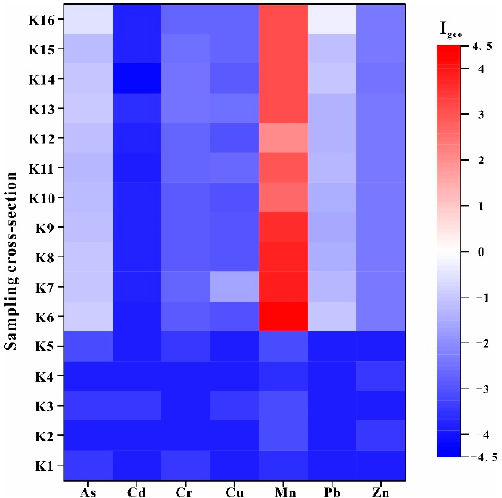
Figure 7. The I geo distribution of PTEs from river sediments.